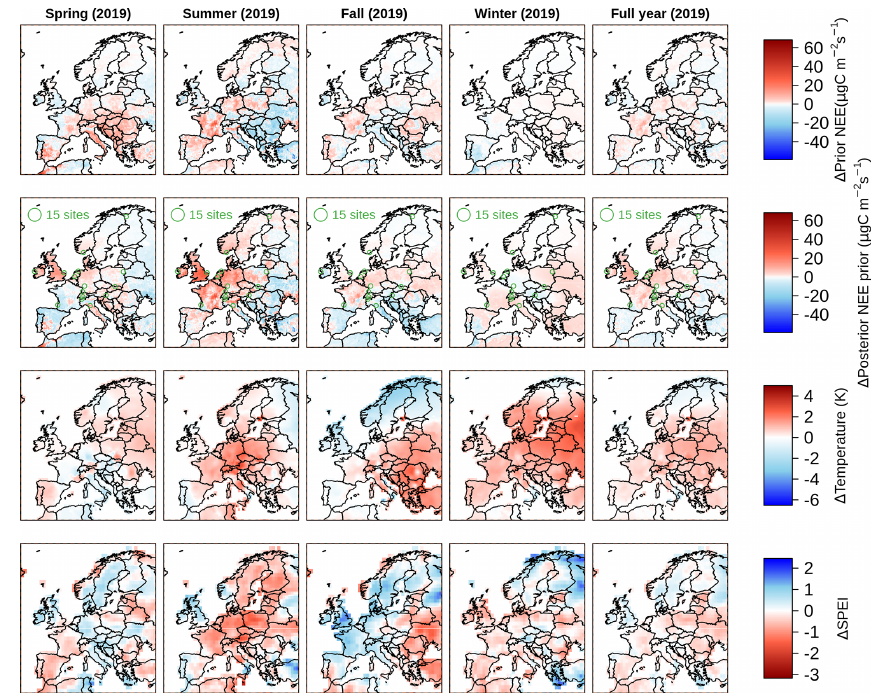
Figure 12. The 2019 anomalies of prior fluxes (first row), posterior NEE estimated from the S1 inversion (second row), 2m air temperature (third row), and SPEI (fourth row) relative to 2006–2019 over Europe. Columns denote mean estimates of spring, summer, fall, winter, and annual NEE estimates, from left to